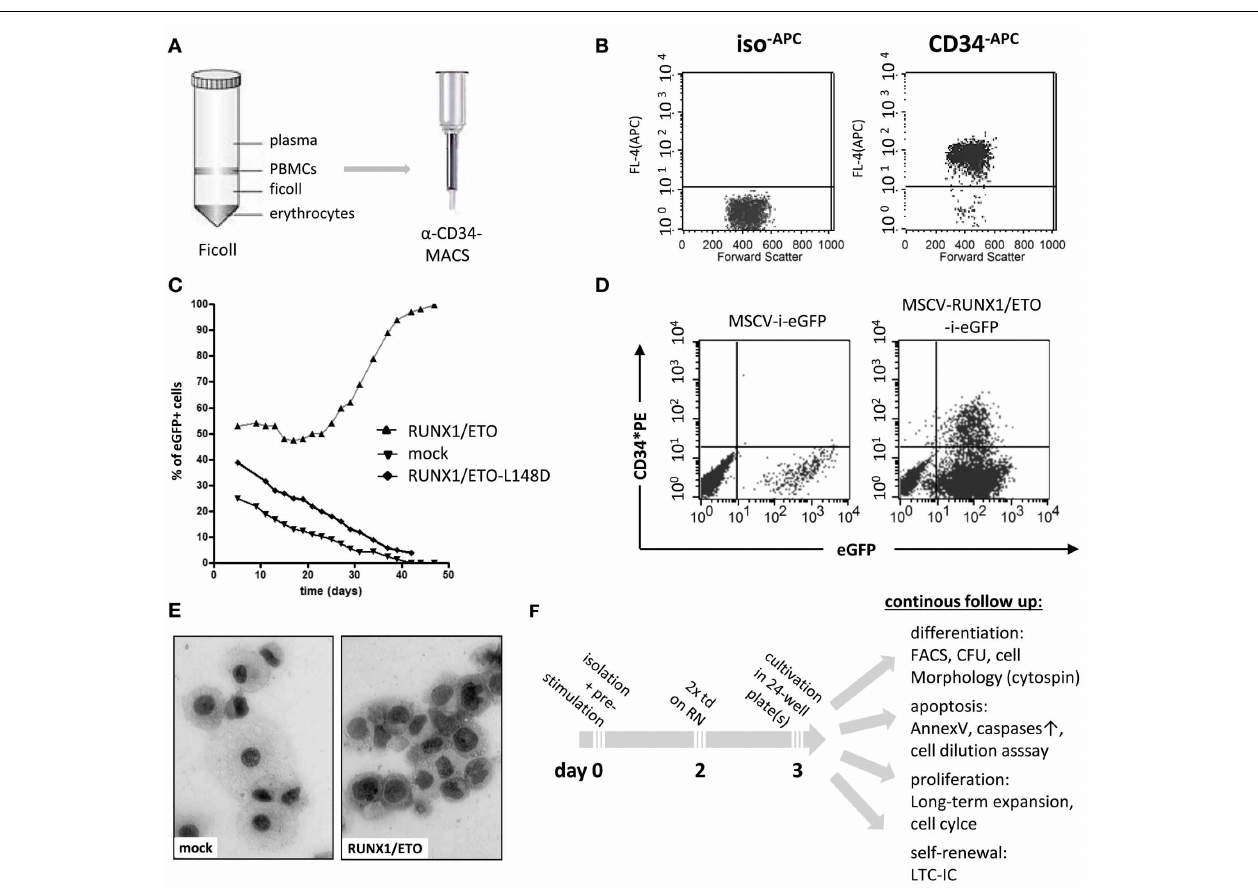
FIGURE 1 | Purification and genetic manipulation of human hematopoietic CD34 + progenitor cells. (A) Isolation of human CD34 + progenitor cells using a Ficoll gradient procedure and MACS column purification following labeling with anti-CD34 microbeads. (B) FACS analysis after MACS showing purified CD34 + cells. (C) Oncogene-mediated selection of RUNX1/ETO-expressing human progenitor cells in ex vivo culture after retroviral transduction with the indicated vectors co-expressing eGFP. RUNX1/ETO-L148D, DNA-binding defective mutant. (D) FACS analysis of